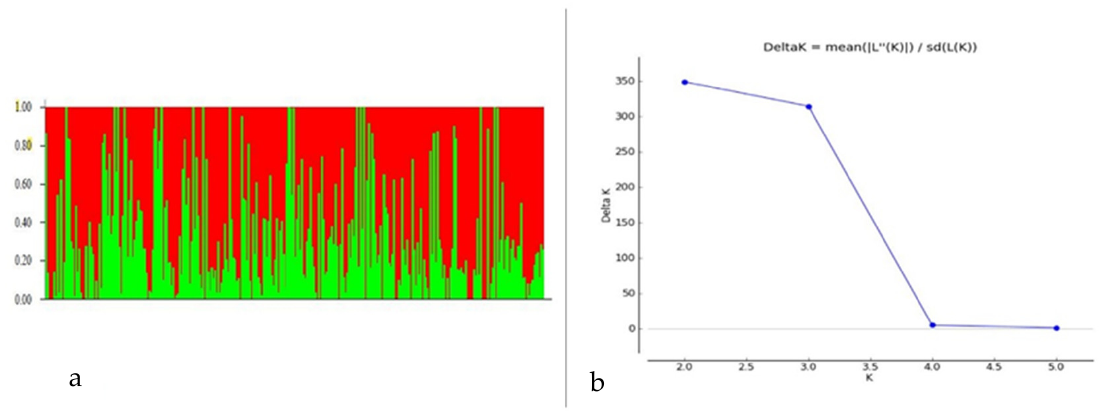
Figure 3. Population structure analysis of the 298 Indian bread wheat genotypes. ( a ) Bar plot indicating membership coefficient (Q value at Y axis). ( b ) Estimation of hypothetical sub-populations using Δ K-values; the maximum value of delta K occurred at K = 2.